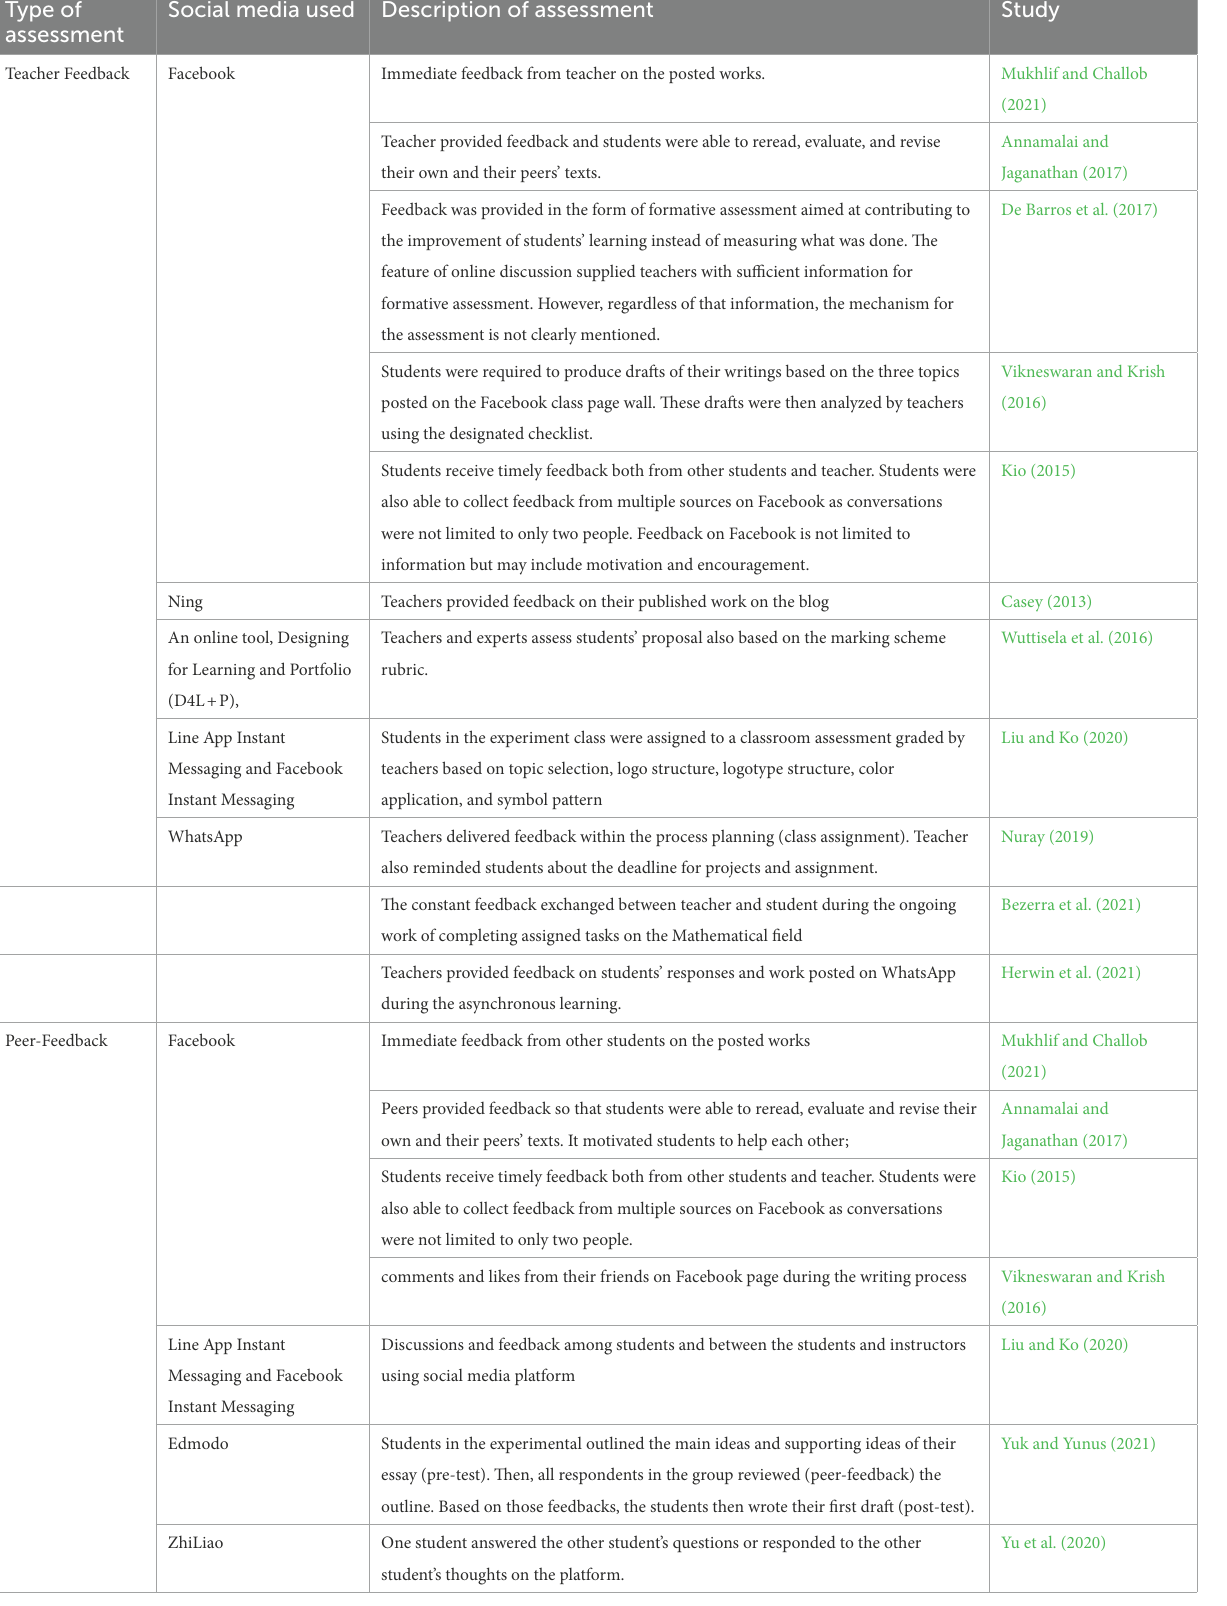
TABLE 3 Social media used for